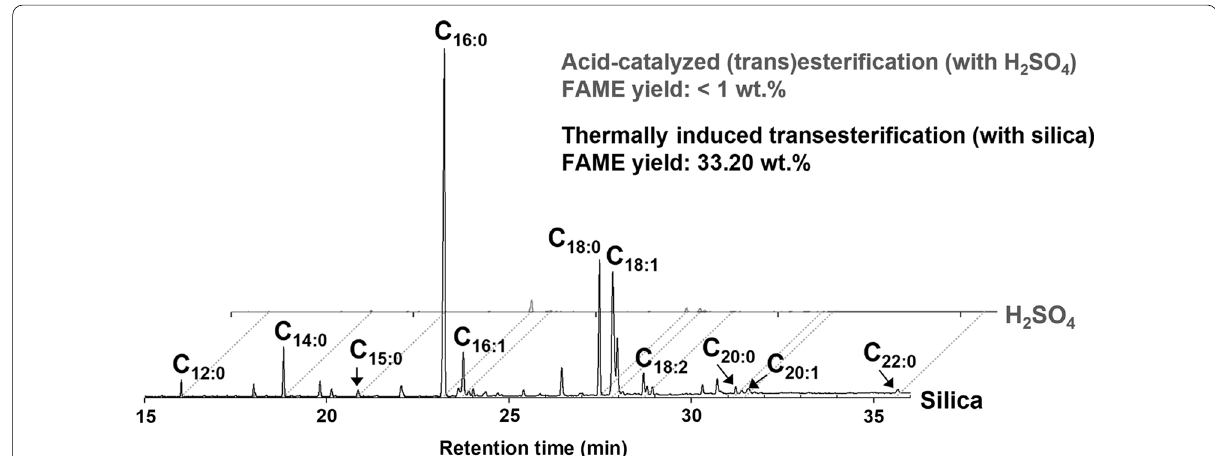
Fig. 3 Chromatogram of FAMEs converted from acid‑catalyzed (trans)esterification (H 2 SO 4 at 60 °C for 24 h) and thermally induced transesterification (silica at 380 °C for 1 min) of